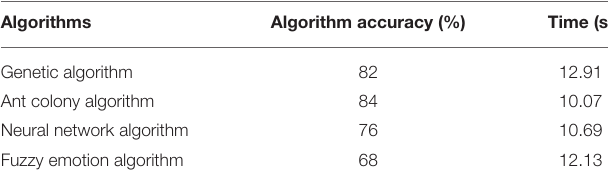
TABLE 3 | Comparison of different intelligent